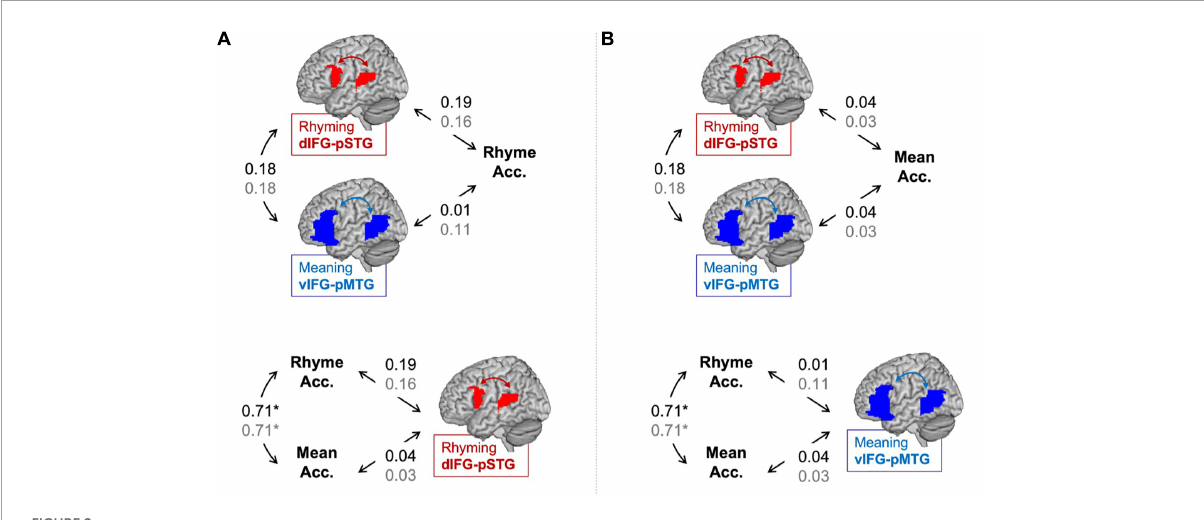
FIGURE2 Partial correlations (controlling for age) between connectivity and in-scanner task accuracy in the lexical > fixation (black) and the target-conditions > fixation (gray) contrasts. Panel (A) tests the hypotheses that the dorsal pathway for phonology is associated with word rhyming accuracy more than the ventral pathway for semantics and that word rhyming accuracy is associated with the dorsal pathway for semantics more than word meaning accuracy. Panel (B) tests the hypotheses that the ventral pathway for semantics is associated with word meaning accuracy more than the dorsal pathway for phonology and that word meaning accuracy is associated with the ventral pathway for semantics more than word rhyming accuracy. Statistically significant correlation denoted by an asterisk. * p <